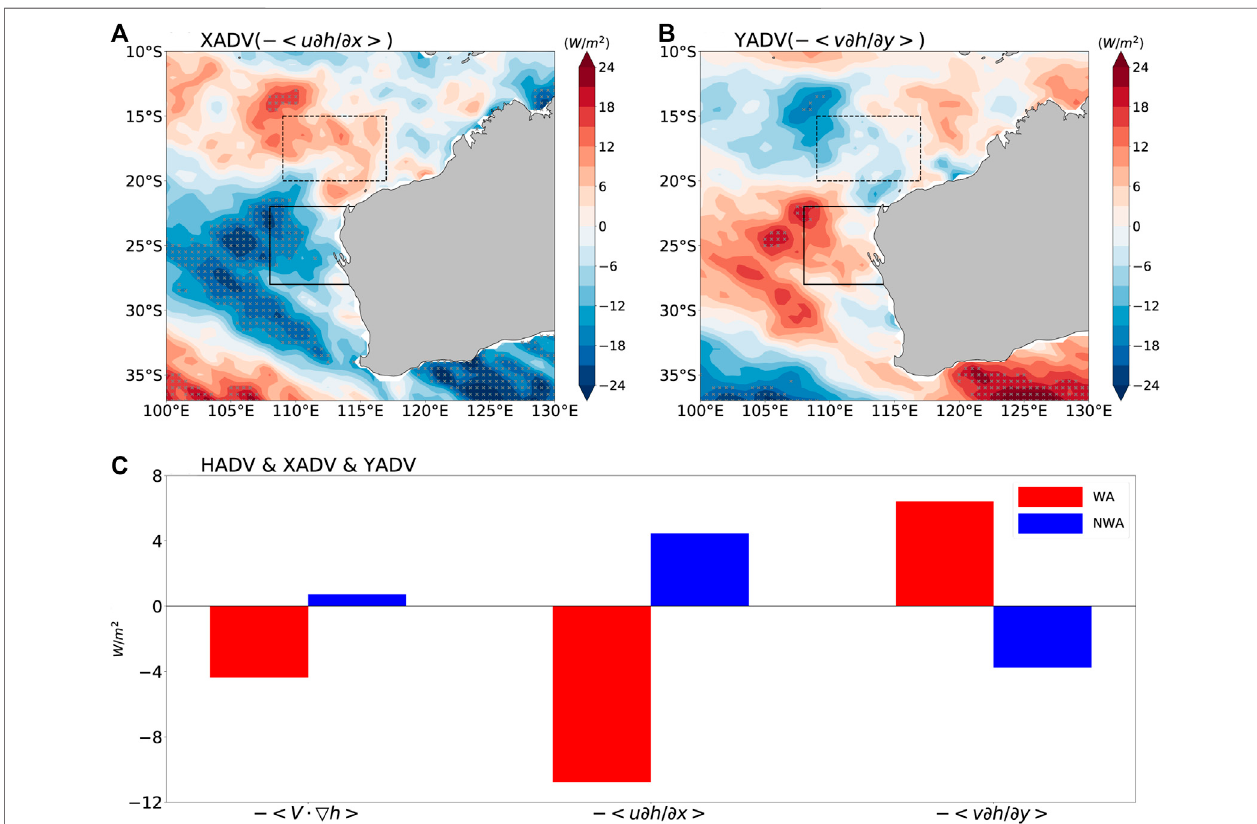
FIGURE 7 | Linear regressions of the austral summer (DJF) mean (A) column-integrated zonal advection of MSE (XADV, W m − 2 ) and (B) column-integrated meridional advection of MSE (YADV, W m − 2 ) against PC1 during 1981 – 2018. The gray crosses indicate the variable anomalies above the 90% signi fi cance level by a Student t test.ThesolidanddashedboxesindicatetheWA(108 ° E-coast,28 – 22 ° S)andNWA(109 – 117 ° E,20 – 15 ° S)coastalregions,respectively. (C) Linearregressions of PC1 with the XADV and YADV terms averaged over the NWA (blue bars) and WA (red bars) coastal regions.